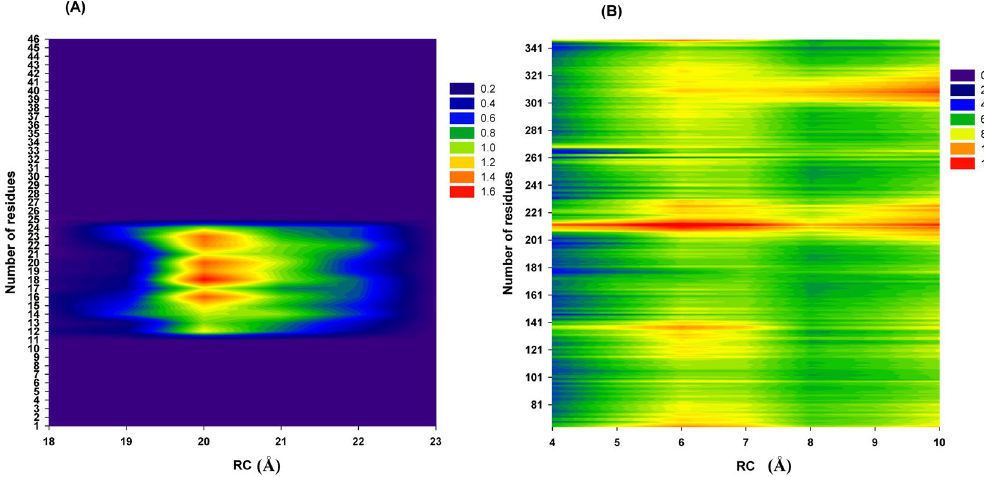
Figure 4. RMSF profiles of MOR with β -funaltrexamine. ( A ) RC: 18–23 Å; the order of the residues is